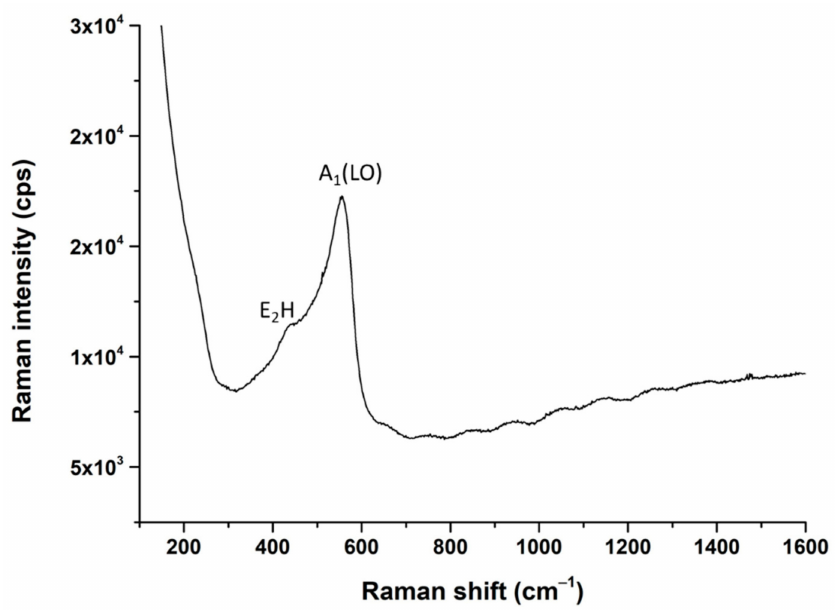
Figure 2. Raman spectra between 100 and 1600 cm − 1 for bare HDG steel in a valley after solvent